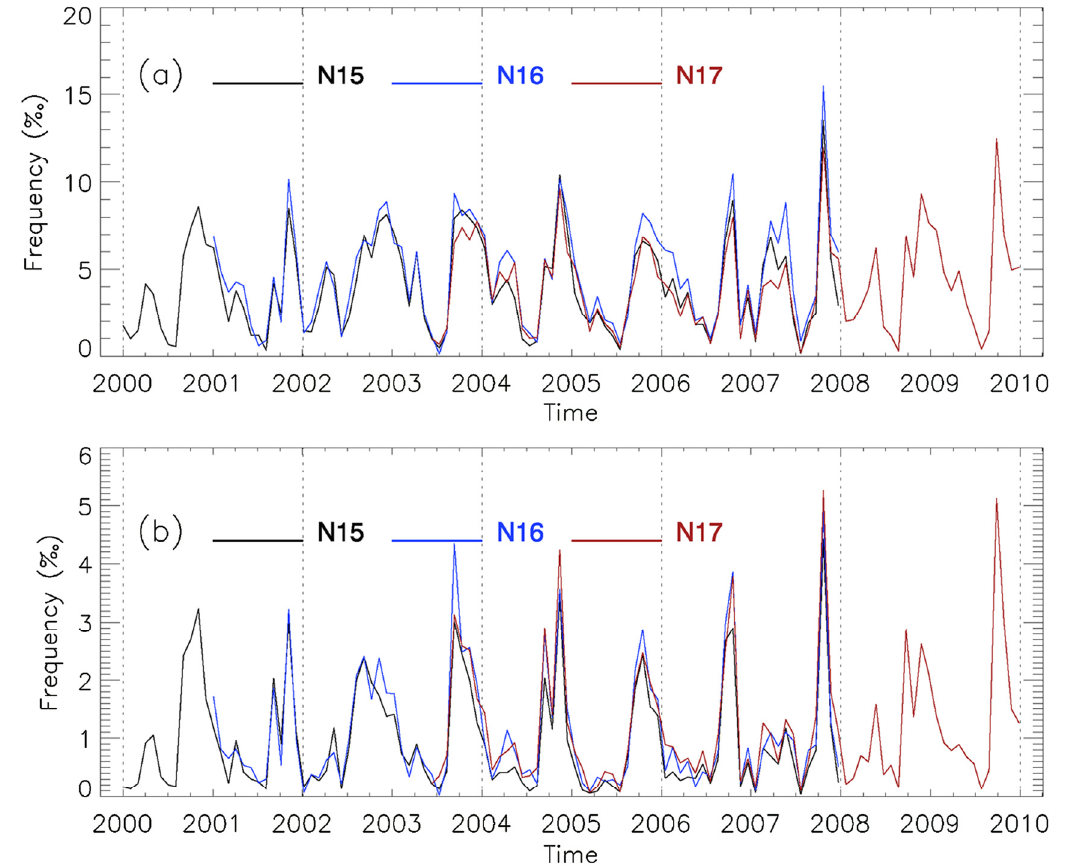
Figure 3. Monthly mean of ( a ) MR and ( b ) DC frequency over the Mediterranean Sea based on NOAA-15 (black), NOAA-16 (blue) and NOAA-17 (red)